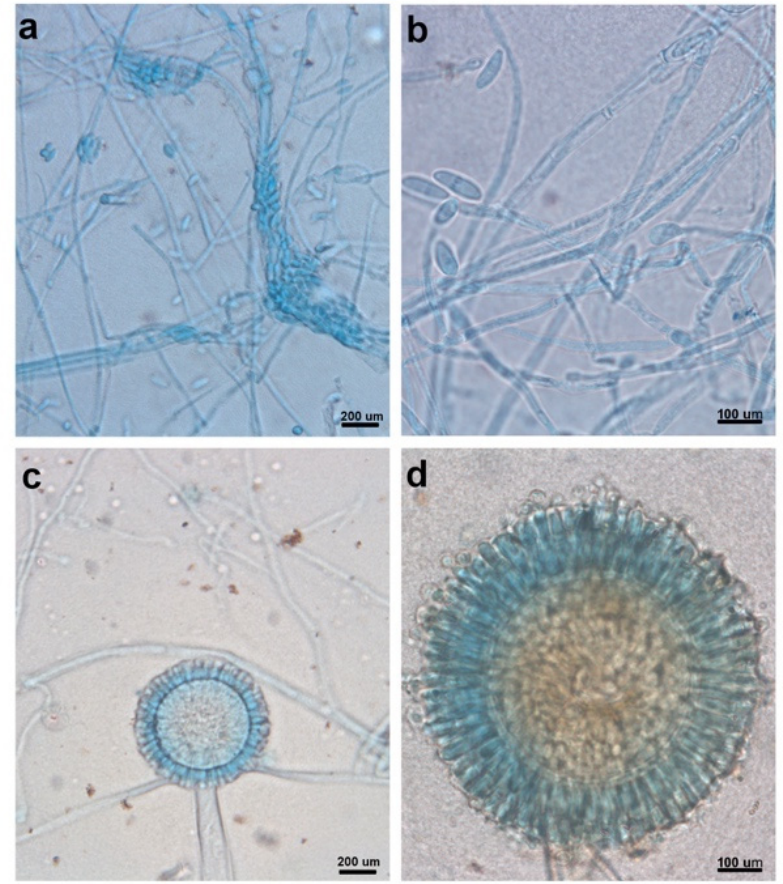
Figure 1. Microscopic observations of reproductive structures from strain H17 ( a and b ) and strain H21 ( c and d ). Scale bars are indicated accordingly ( a and c : 200 μ m; b and d : 100 μ m).